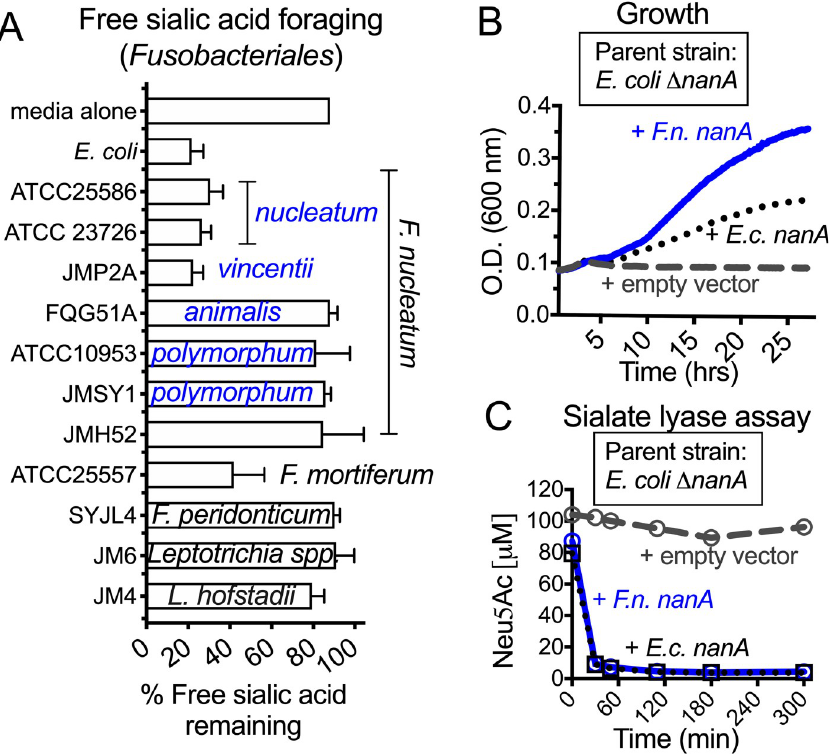
Fig 1. Analysis of sialic acid utilization by Fusobacteria and functional evidence of F . nucleatum -encoded sialate lyase ( nanA ). (A) Amount of sialic acid remaining in the growth medium 24–48 h postinoculation of different Fusobacteria (as indicated) or uninoculated media control. Subspecies of F . nucleatum are indicated in blue text. All Fusobacteria were grown in supplemented Columbia medium with free sialic acid added (Neu5Ac, 100 μ M)—medium that was also used as uninoculated control. E . coli (MG1655), a known sialic acid consumer, cultured in LB medium with added free sialic acid (Neu5Ac, 100 μ M) was included as a positive control. Error bars shown are standard deviation of the mean from 3 independent experiments. (B–C) E . coli MG1655 Δ nanA was complemented with empty vector, E . coli nanA or putative nanA from F . nucleatum ATCC23726 (GenBank accession EFG95907). Data shown are representative of 3 independent experiments. (B) Growth was assessed in minimal media with sialic acid by measuring absorbance at 600 nm. (C) Lysates of the E . coli nanA mutant with empty vector or the complemented strain were incubated with sialic acid (Neu5Ac), and its disappearance was monitored over time by fluorescent derivatization (with DMB) followed by HPLC. The underlying numerical data for this figure can be found in S1 Data. Strain names: FQG51A, JM6, JM4, JMH52, JMP2A, JMSY1, SYJL4. Description of bacterial strains can be found in S1 Table. ATCC, American Type Culture Collection; DMB, 1,2-diamino-4,5-methylenedioxybenzene; E . c ., E . coli ; F . n ., F . nucleatum ; HPLC, high-performance liquid chromatography; LB, lysogeny broth; nanA , N -acetylneuraminate lyase; Neu5Ac, N - acetylneuraminic acid; OD, optical density. (Neu5Ac) (Fig 2D), even though both strains grew similarly in the nutrient-rich media used for this experiment (S2 Fig). F . nucleatum is a fastidious anaerobe, and single-carbon–source experiments are not feasible as an experimental strategy. Therefore, we developed a nutrient- limited media containing some of the base components of Columbia media, as described in the Methods. Reducing the nutrient content of the growth media made it possible to investi- gate the impact of sialic acid foraging on the growth of F . nucleatum when resources are lim- ited. Experiments were performed in nutrient-limited media with or without added carbohydrate sources. Briefly, WT and O siaT were inoculated into a nutrient-limited medium, either with no added carbohydrate or with added monosaccharides—glucose or free sialic acid (Neu5Ac). Both WT and O siaT grew poorly in low-carbohydrate medium, reaching a plateau at an optical density (OD) of approximately 0.25, and both grew well in medium containing 600